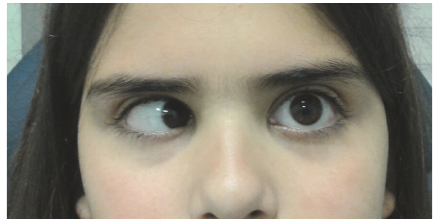
Figure 1: Left gaze position, showing complete left sixth nerve palsy. The child was 9 years old at the time of this photograph. Informed consent has been obtained from a parent of the child to publish this